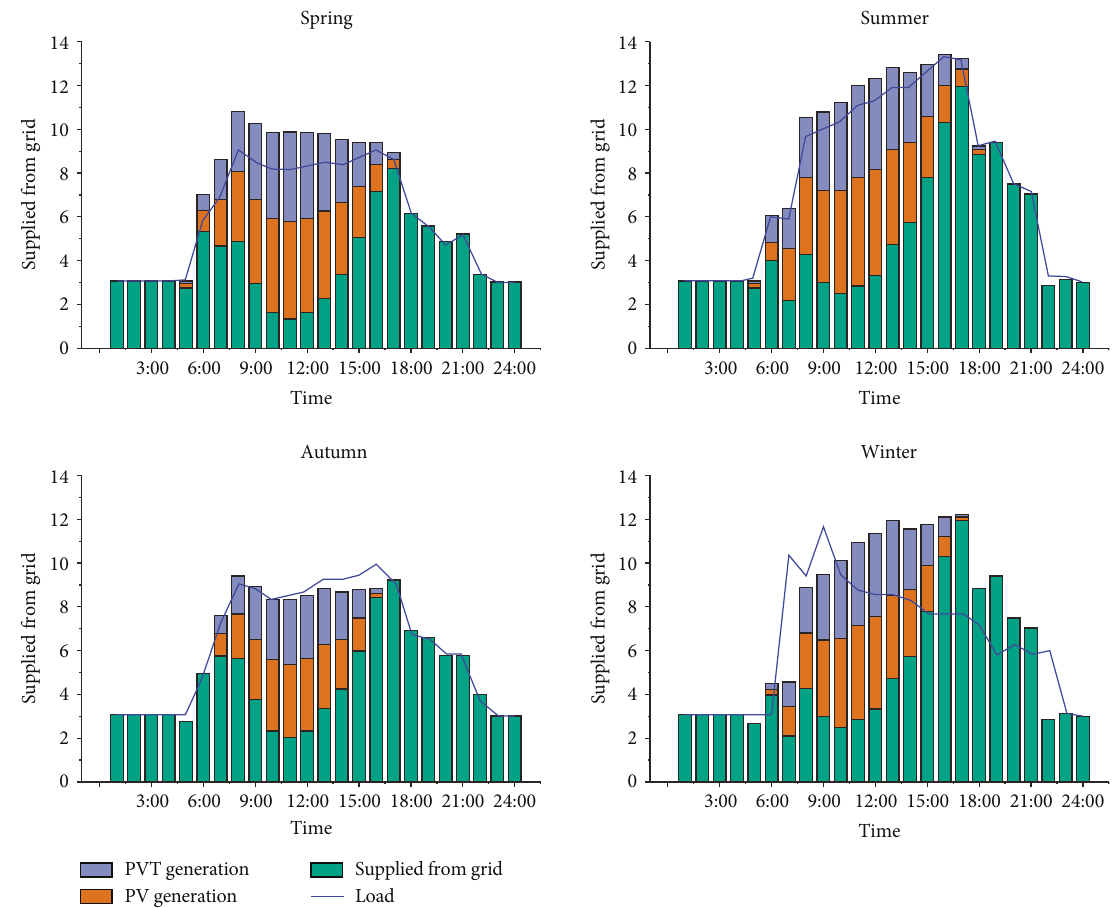
Figure 14: Energy structure in the proposed energy hub for di ff erent days of the four